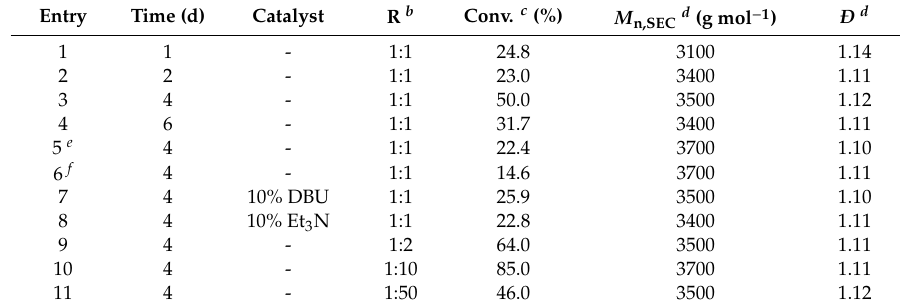
Table 2. Optimization studies for selenol-based nucleophilic reaction of PS-Se-1 with PEGMA 950 a.